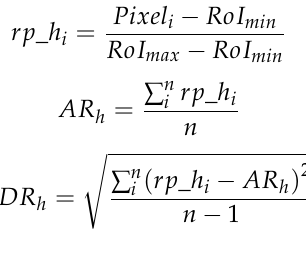
Figure 4. Visual description examples of the hand-crafted color feature matrix. The images within the red dashed line are the visual descriptions of the matrix generated by the original images. Taking the longitudinal relative spatial information as an example, the average relative height ( AR h ) and relative height standard deviation ( SDR h ) are defined as (2) and (3), respectively.